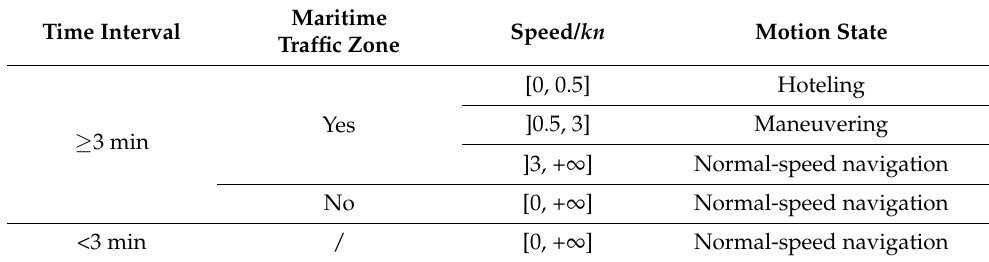
Table 3. Ship motion characteristics in port